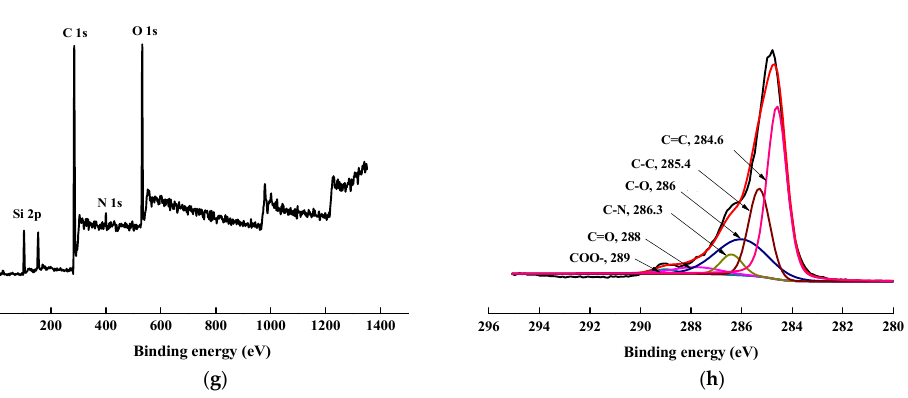
Figure 8. XPS wide scan and C 1s core-level spectra of AF before and after modification. ( a ), ( b ): AF0; ( a-1 ), ( b-1 ): AF0-T; ( c ), ( d ): AF1; ( e ), ( f ): AF2; ( g ), ( h ): AF3. Table 2. Relative chemical composition and atomic ratios determined by XPS for AF before and after processing.